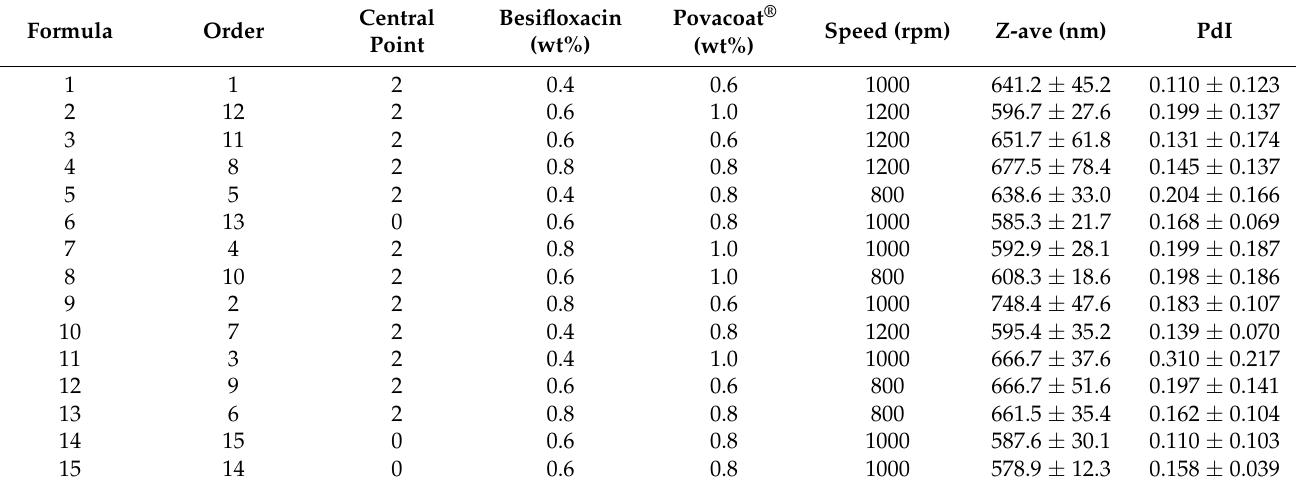
Table 2. Box–Behnken experimental design and observed responses. Average hydrodynamic diameter (Z-ave) in nm was obtained for the besifloxacin nanocrystal preparations. Conditions: 30% (m/m) zirconium beads and 2 magnetic bars, 25 ◦